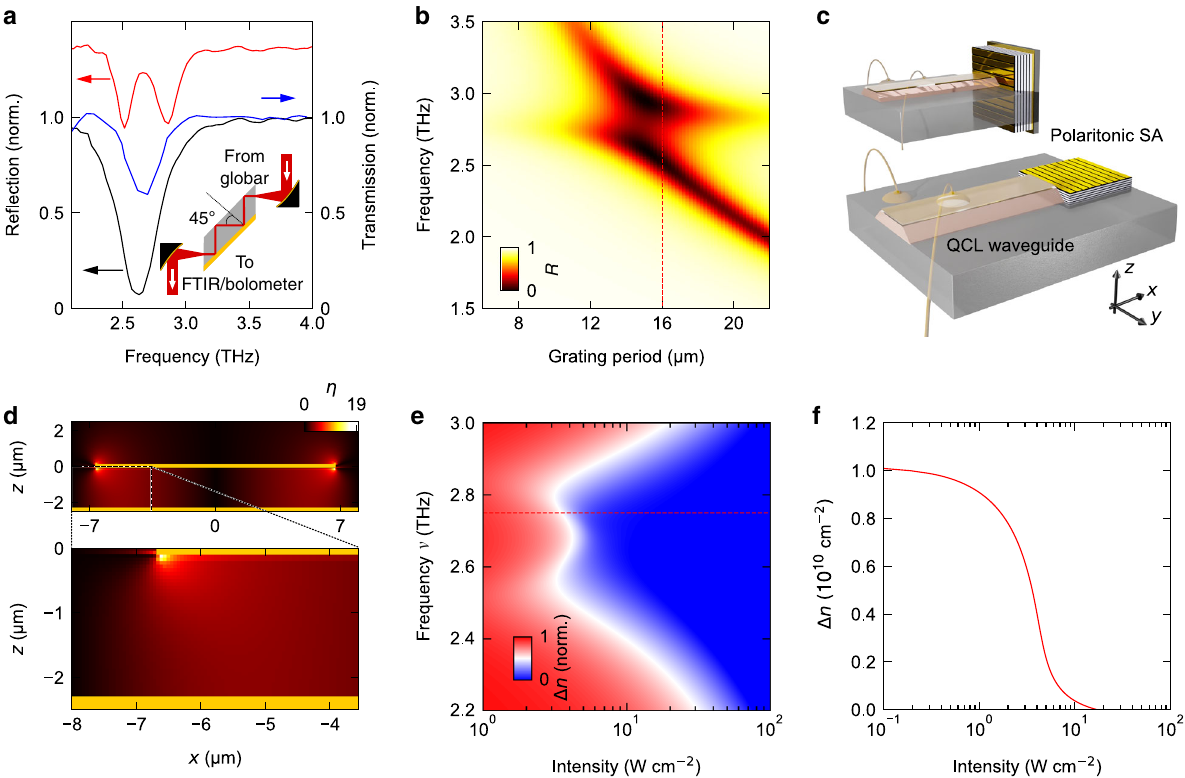
Fig. 1 Polaritonic saturable absorber structure. a Re fl ectivity spectra of the coupled structure measured at T = 300 K (black curve) and at 6 K (red curve). The blue curve shows the transmission through the QW slab with three internal re fl ections, measured in a transmission geometry as shown in the inset. b Calculated re fl ectivity R as a function of the grating period. The red, dashed line highlights the con fi guration of our sample with a grating period of 16 µ m and polariton resonances located at frequencies of ν LP = 2.52 THz and ν UP = 2.85 THz, respectively. c Schematics of possible options of the QCL design showing the laser structure and the SA replacing one of the laser ’ s end mirrors. The coordinate systems de fi ne the directions x , y and z used throughout the manuscript. d z -component of the near- fi eld enhancement relative to the incident fi eld amplitude, η , within a cross-section of the cavity (top panel), and magni fi cation of the area highlighted by the black rectangle (bottom panel). e Population inversion Δ n = n 1 − n 2 , where n 1 and n 2 are the populations of fi rst and second subband, respectively, as a function of pump intensity and pump frequency, ν , calculated using a rate equation model. Red dashed line, ideal pump frequency for saturation. f Population inversion Δ n as a function of pump intensity, extracted from the data shown in e , at 2.75 modi fi ed, increasing intensities (purple curves) lead to a satura- tion and a reduction of the polariton splitting, resulting from bleaching of the ISB transition. Eventually, for I p = 11 W cm − 2 (red curve), Ω R is strongly reduced and the polariton resonances partially merge, as expected from the simulation results of Fig. 1e.